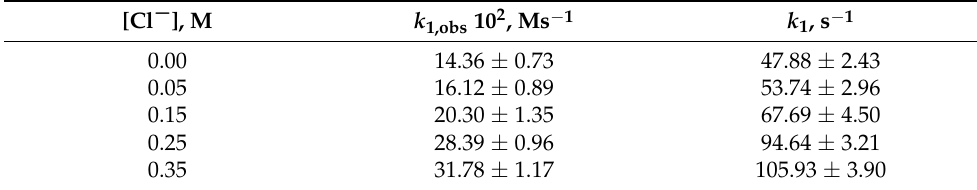
Table 3. Values of the observed pseudo-zero- and zero-order rate constants (average of six indepen- dent kinetic experiments) for the reaction between platinum(IV) chloride complex ions and sodium borohydride at different Cl ¯ concentrations. Conditions: C 0,Pt(IV) = 0.05 mM, C 0,NaBH4 = 3.0 mM,